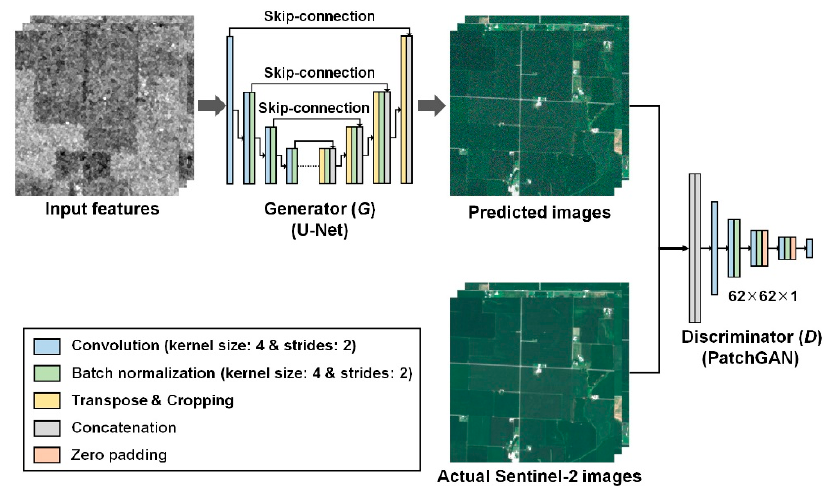
Figure 9. Pix2Pix architecture employed in the generation stage.